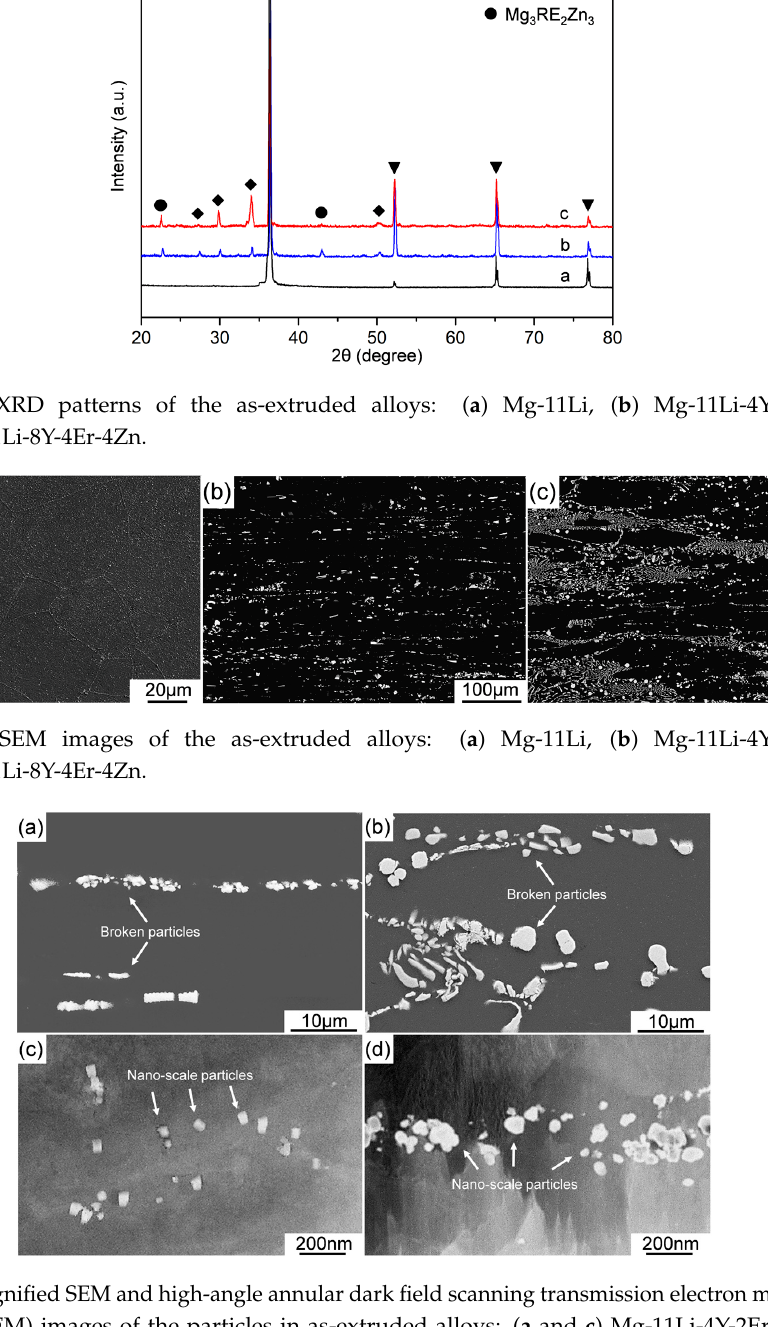
Figure 7. Magnified SEM and high-angle annular dark field scanning transmission electron microscopy (HAADF-STEM) images of the particles in as-extruded alloys: ( a and c ) Mg-11Li-4Y-2Er-2Zn and ( b and d ) Mg-11Li-8Y-4Er-4Zn.